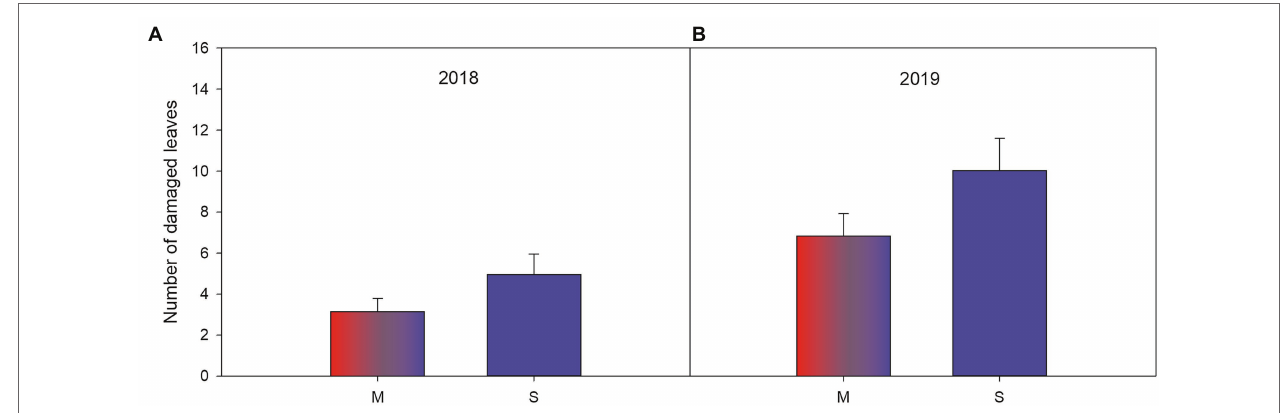
FIGURE 4 | Significant associational effects ( Tables 3A,B ) of plant resistance (varieties growing either among plants with homogenous resistance level, i.e., in susceptible-only plot, vs. growing in a resistance mixture with both resistant and susceptible varieties) on number of herbivore damaged leaves on susceptible woodland strawberry ( Fragaria vesca ) plants in (A) 2018 during the last scoring occasion and (B) in 2019. Letters along the x-axis indicate S = susceptible varieties (blue) and M = 50:50 mixture of both resistant and susceptible varieties (red and